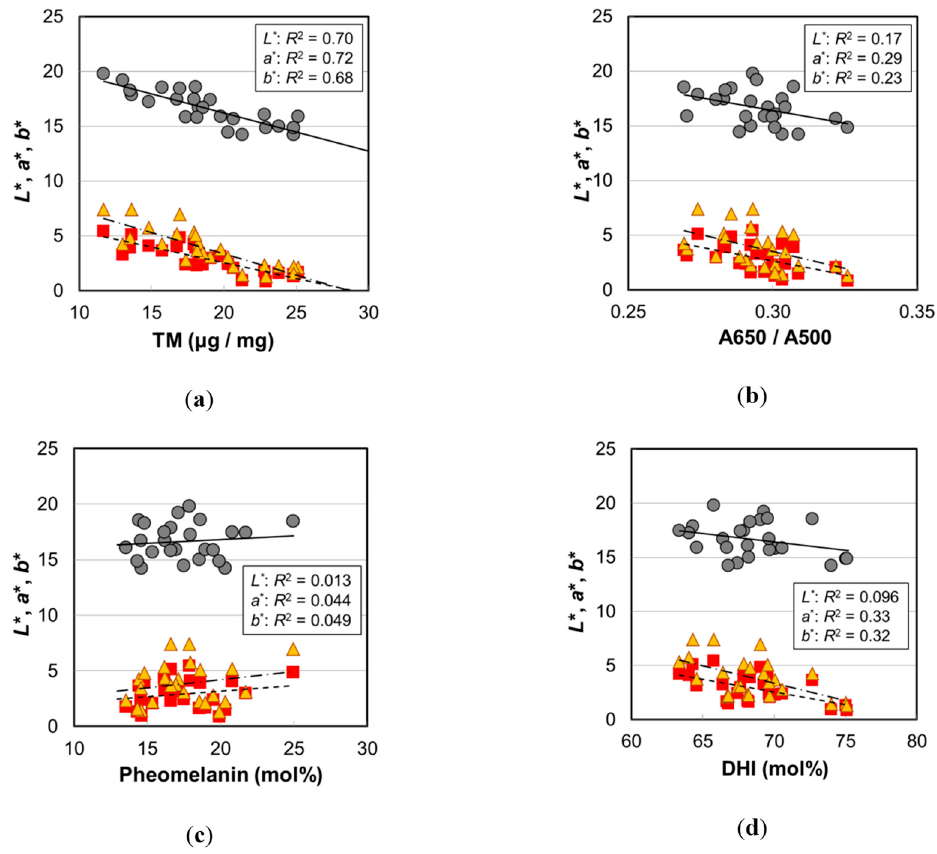
Figure 7. The hair color parameters ( L * , a * , and b * ) of the Japanese female hair samples plotted against various values measured by hair melanin analyses. Circles, L * ; squares, a * ; triangles, b * . Lines are the fitted curves. Solid lines, L * ; dashed lines, a * ; dot-and-dash lines, b * . ( a ) The color values vs. total melanin amount, p = 2.2 × 10 − 7 ( L * ), 1.0 × 10 − 7 ( a * ), and 3.9 × 10 − 7 ( b * ); ( b ) vs. A650 / A500, p = 0.043 ( L * ), 0.0054 ( a * ), and 0.015 ( b * ); ( c ) vs. pheomelanin mol%, p = 0.59 ( L * ), 0.31 ( a * ), and 0.29 ( b * ); ( d ) vs. DHI mol%, p = 0.13 ( L * ), 0.0027 ( a * ), and 0.0032 ( b * ). The coefficients of determination are shown in each figure.